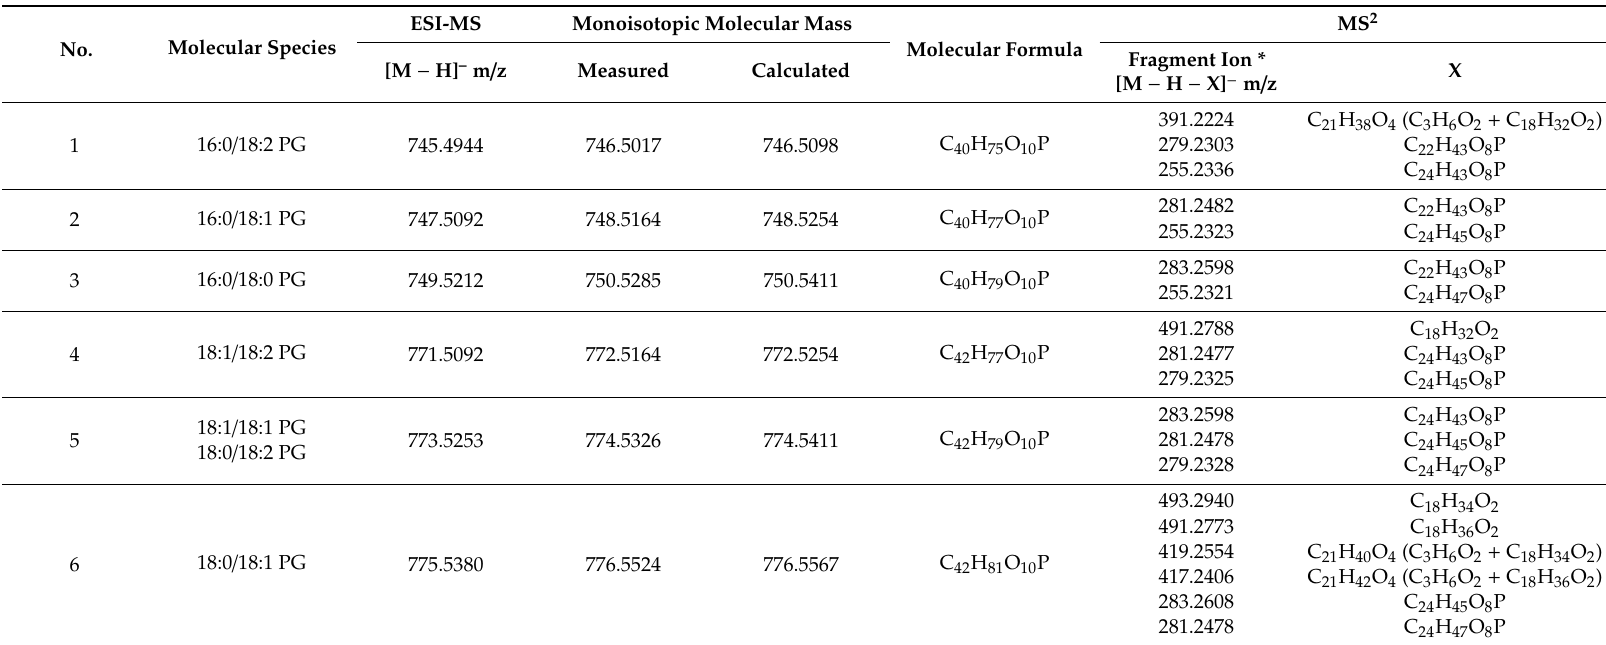
Table 6. Molecular species of phosphatidylglycerol (PG) from Madhuca ellitica